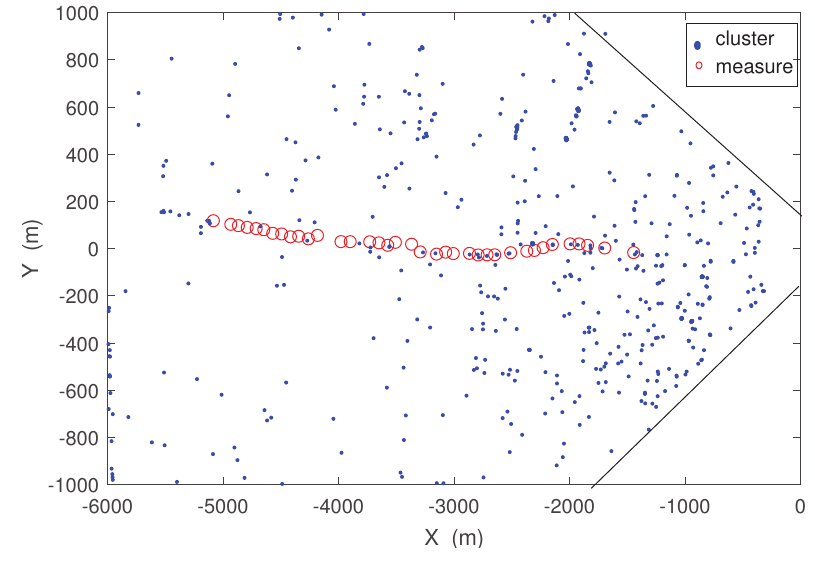
Figure 4. Real-world scenario.